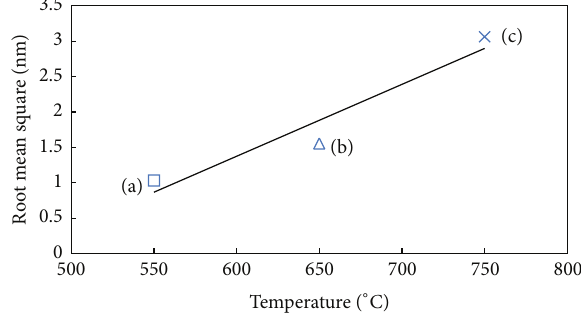
Figure 10: Graph for roughness average versus annealing tempera- ture.